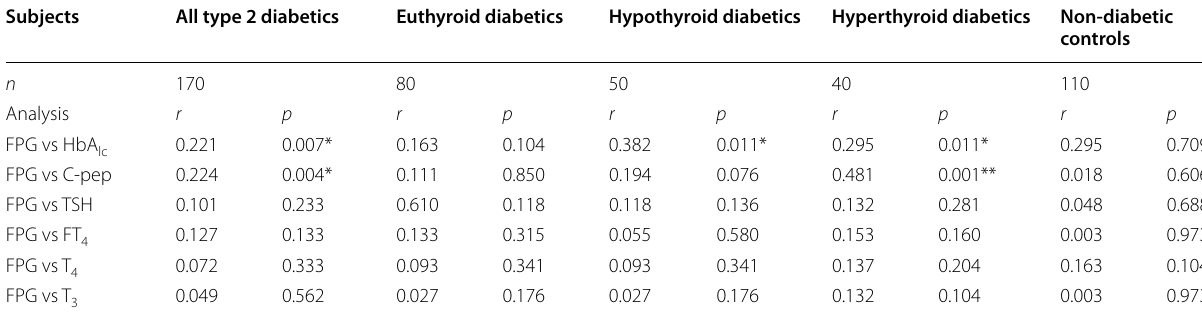
tide and FT 4 only in the hyperthyroid group ( r P 0.042) and negative correlation between C-pep and = Table 1 Correlation analysis between FPG and C-pep, HbA hyperthyroid diabetic and non-diabetic control subjects